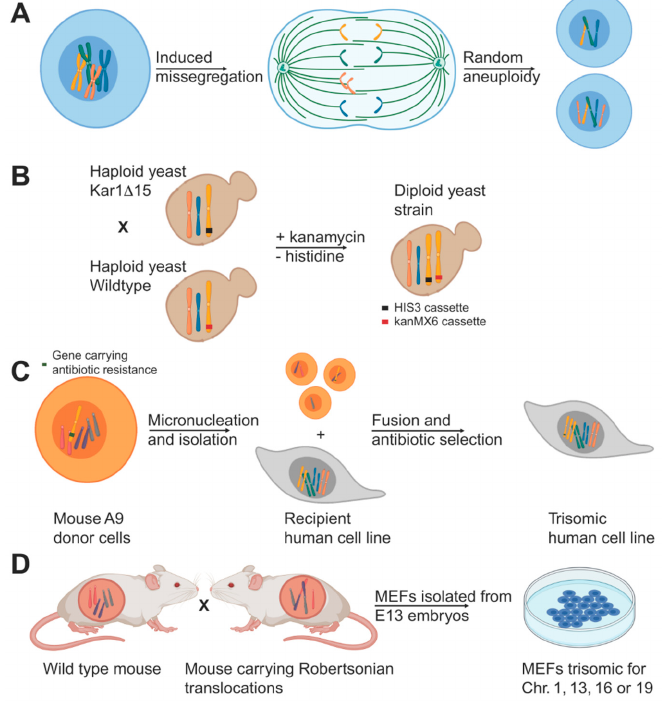
Figure 1. Examples of some of the aneuploidy model systems. ( A ) Induced chromosome mis-se- gregation by weaking the spindle assembly checkpoint using drug treatment or RNAi generates cells with random aneuploidies. ( B ) Disomic yeast cells can be generated by mating wild type yeast with yeast carrying a KAR1 mutation. Lack of KAR1 interferes with nuclear fusion and occasionally leads to random chromosome transfer and aneuploidy. Different antibiotic selection markers on the chromosomes allow for the selection of disomic cells in a haploid background. ( C ) Micronuclei- mediated chromosome transfer can be used to generate human aneuploid cells. For this, mouse donor cells carrying an additional human chromosome undergo micronucleation upon prolonged colcemid treatment and subsequent cell division. Isolated micronuclei carrying one or more chromosomes are fused with human acceptor cells. Aneuploid cells are selected for using a selection marker on the aneuploid chromosome. ( D ) Mating of wild type mice with mice carrying a Robertsonian translocation produces embryos with aneuploid karyotypes. Harvesting of cells from E12.5 embryos from these crosses allowed for the generation of trisomic